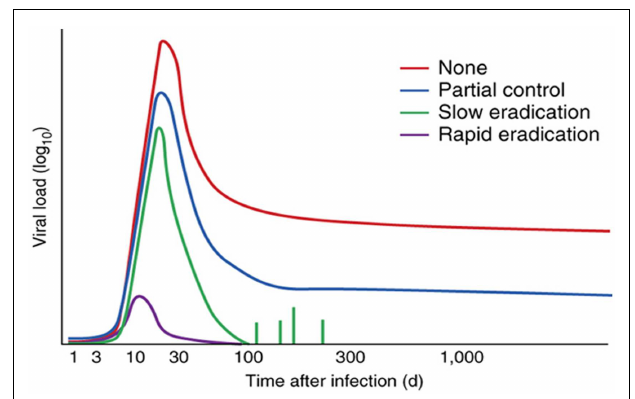
FIGURE 1 | Control of HIV-1 by vaccines that stimulate CTLs . Effect of variousT cell-stimulating vaccines (key) on viral load over time (with infection on day 0) during natural infection with HIV or SIV, showing the decrease in viral load achieved without a vaccine (none), by CTL responses [partial control; as in Ref. (92), for example], by the RhCMV vaccine (slow eradication) (60, 61) and by a hypothetical vaccine that targets the virus at the site of infection (rapid eradication). Reproduced with permission from Ref.